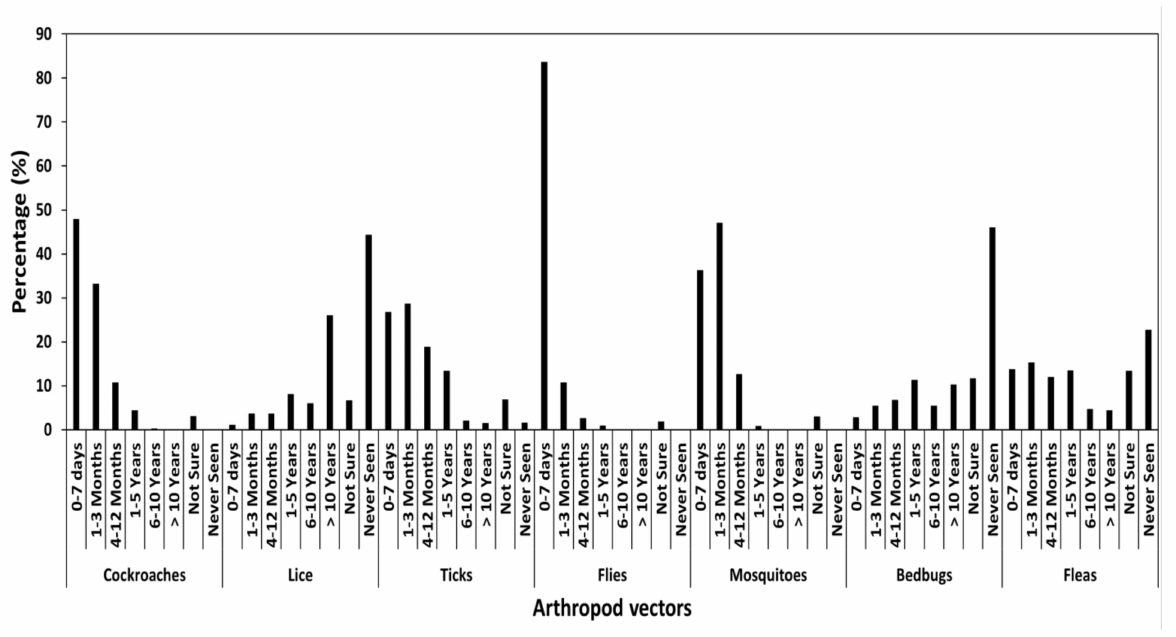
Figure 2. Summary of responses (%) of respondents who reported seeing arthropod vectors over different